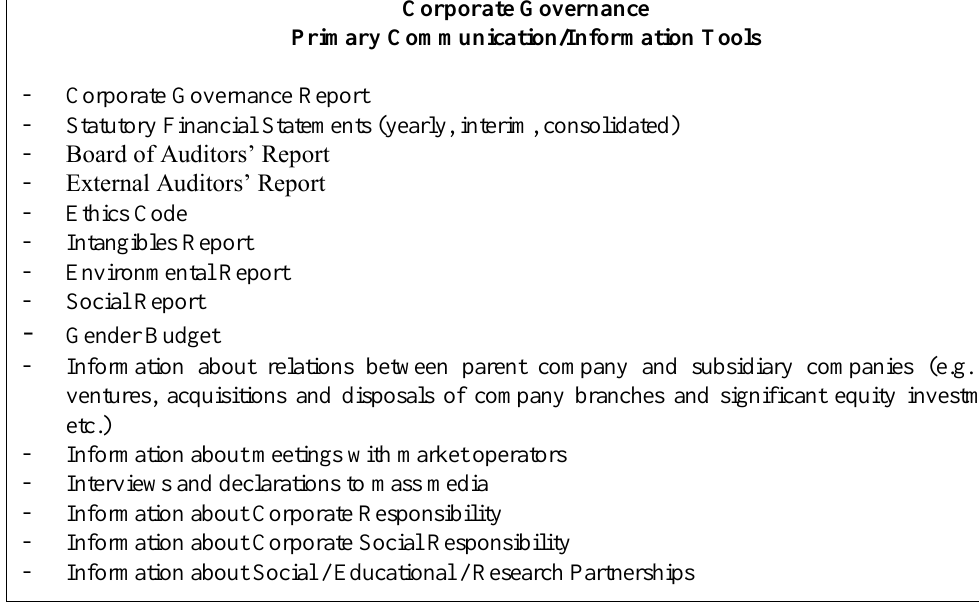
Figure 2: Corporate Governance – Communication and Information Tools Corporate